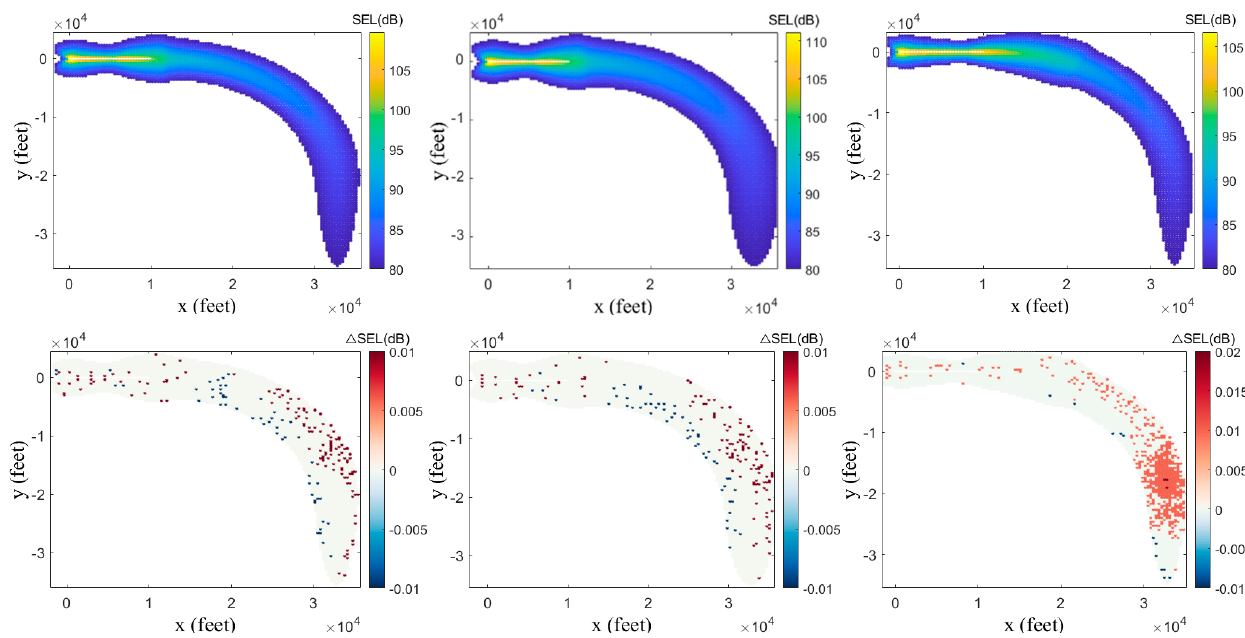
Figure 5. Noise contour map (top) and corresponding error (bottom) for JETFDC (left), JETWDC (center), PROPDC (right) cases.